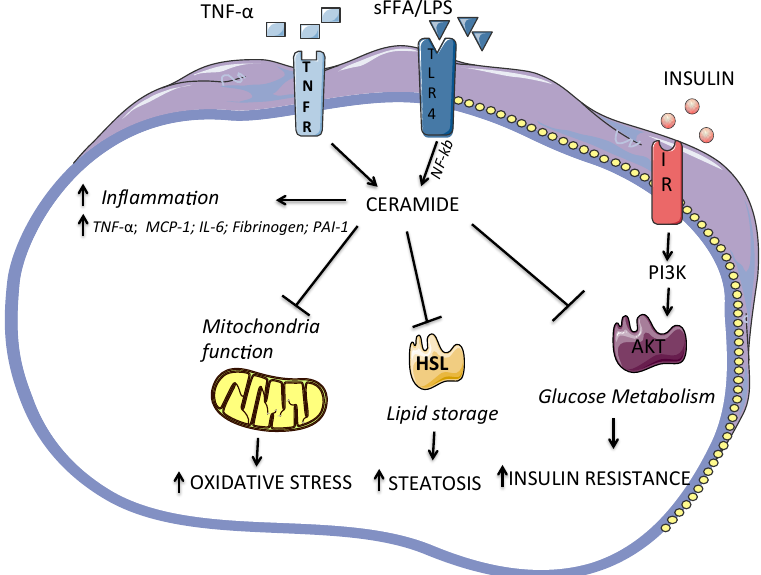
Figure 2. Ceramide accumulation leads to deleterious effects such as the inhibition of Akt to abrogate insulin signaling, promoting excessive lipid storage by inhibiting HSL (hormone-sensitive lipase), inhibits mitochondrial capacity leading to oxidative stress. Moreover, ceramides accumulation increments inflammation by the release of several pro-inflammatory cytokines. Akt: protein kinase B; PI3K: phosphatidylinositol-3-kinase; LPS: lipopolysaccharide; NF-κB: nuclear factor kappa-light-chain-enhancer of activated B cells; PAI-1: plasminogen activator inhibitor 1; sFFA: saturated fatty acids; TLR4: toll-like receptor 4; TNF-α: tumor necrosis factor alpha; IL-6: interleukine6; TNFR: tumor necrosis factor alpha receptor; MCP-1: monocyte chemoattractant protein-1; IR: insulin receptor.